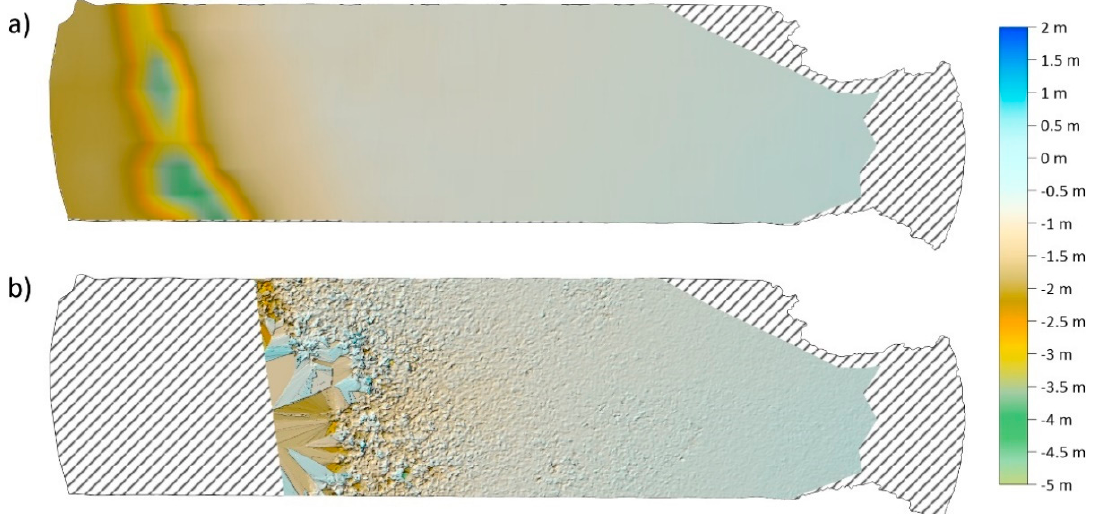
Figure 9. BRS surface developed by the TIN method from USV data in the sounding domain ( a ) and the corresponding surface developed from UAV data ( b ). View within the limits of the complete development of the digital bathymetric model.